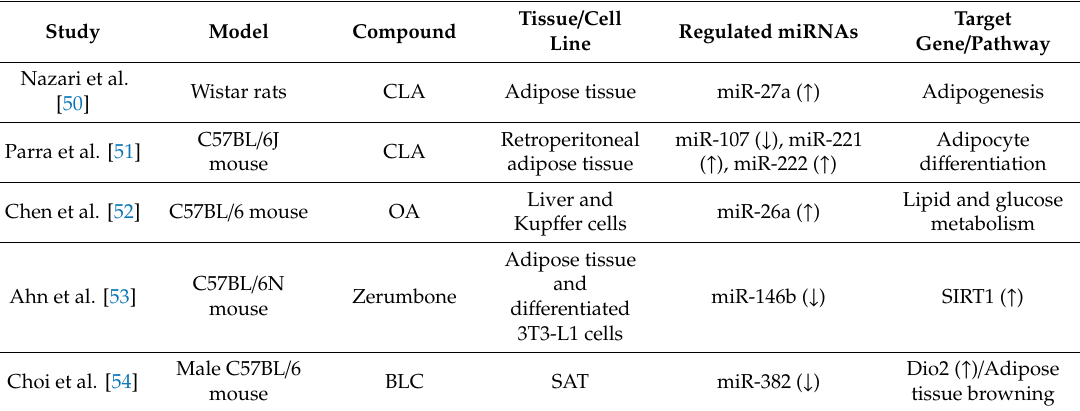
Table 2. Studies that evaluated microRNA expression changes after administration of fatty acids and di ff erent plant-derived